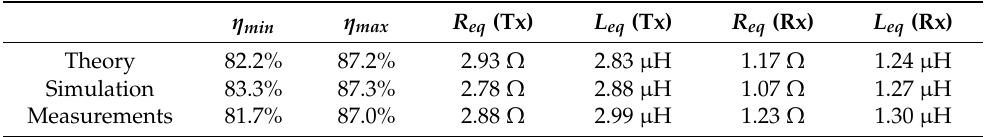
Table 2. Comparative table of the theoretical, simulation, and experimental results of the efficiency and electrical parameters at 13.56 MHz .